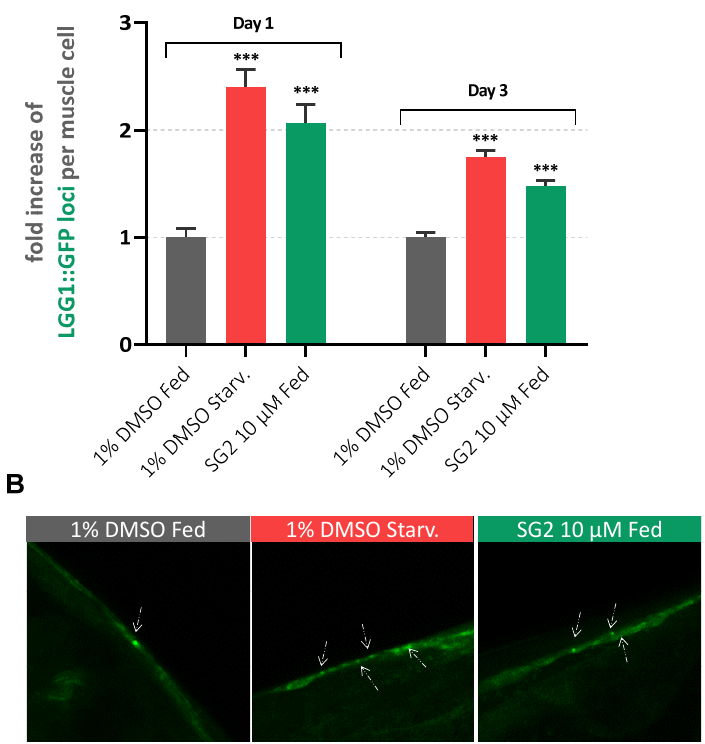
Figure 3. SG2 enhances autophagy in a C. elegans model of AD. ( A ) GFP structures were counted in 3 different conditions (Fed: 1% DMSO; Starved: 1% DMSO and 6 h of starvation; Treated: 10 µM SG2 in 1% DMSO) of approximately 25–30 worms from two different biological experiments. Bars represent average number of GFP structures normalized to control (Fed) + SEM. For statistical tests, One-Way ANOVA was used p < 0.001 ***. ( B ) Representative pictures of big muscles cells presenting LGG-1:GFP puncta with white arrows highlighting LGG-1::GFP structures.